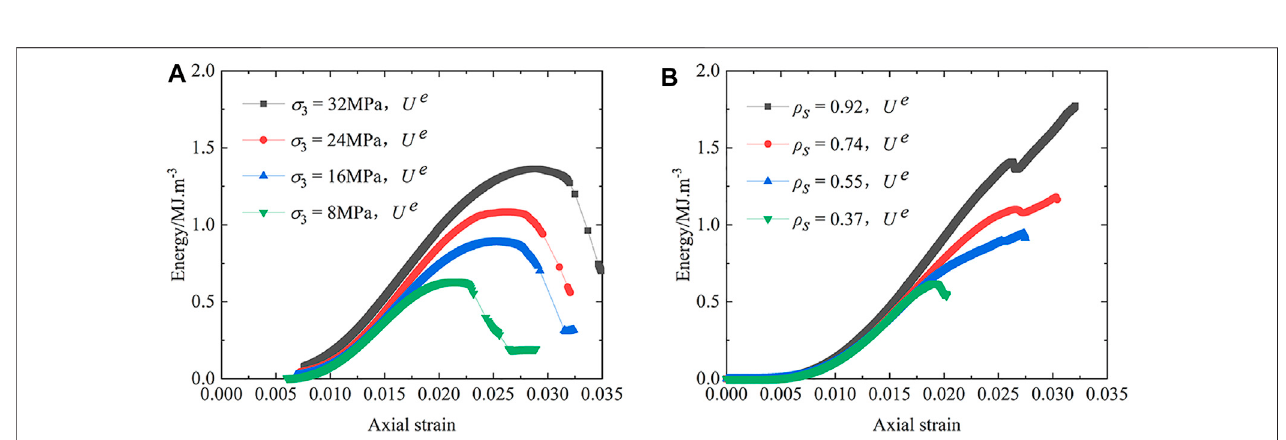
FIGURE 9 | Energy evolution curve of elastic energy under different con fi ning conditions. (A) Constant con fi ning stress; (B) constant con fi ning stiffness.